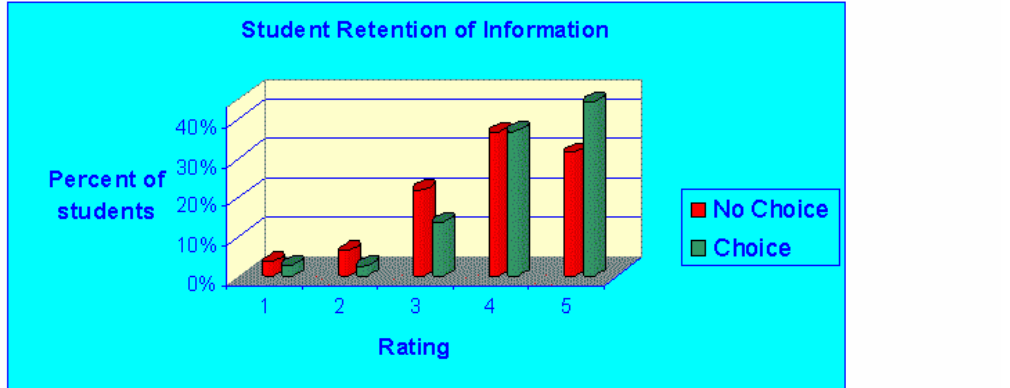
Figure 3. Student retention* of "Choice" and "No Choice"